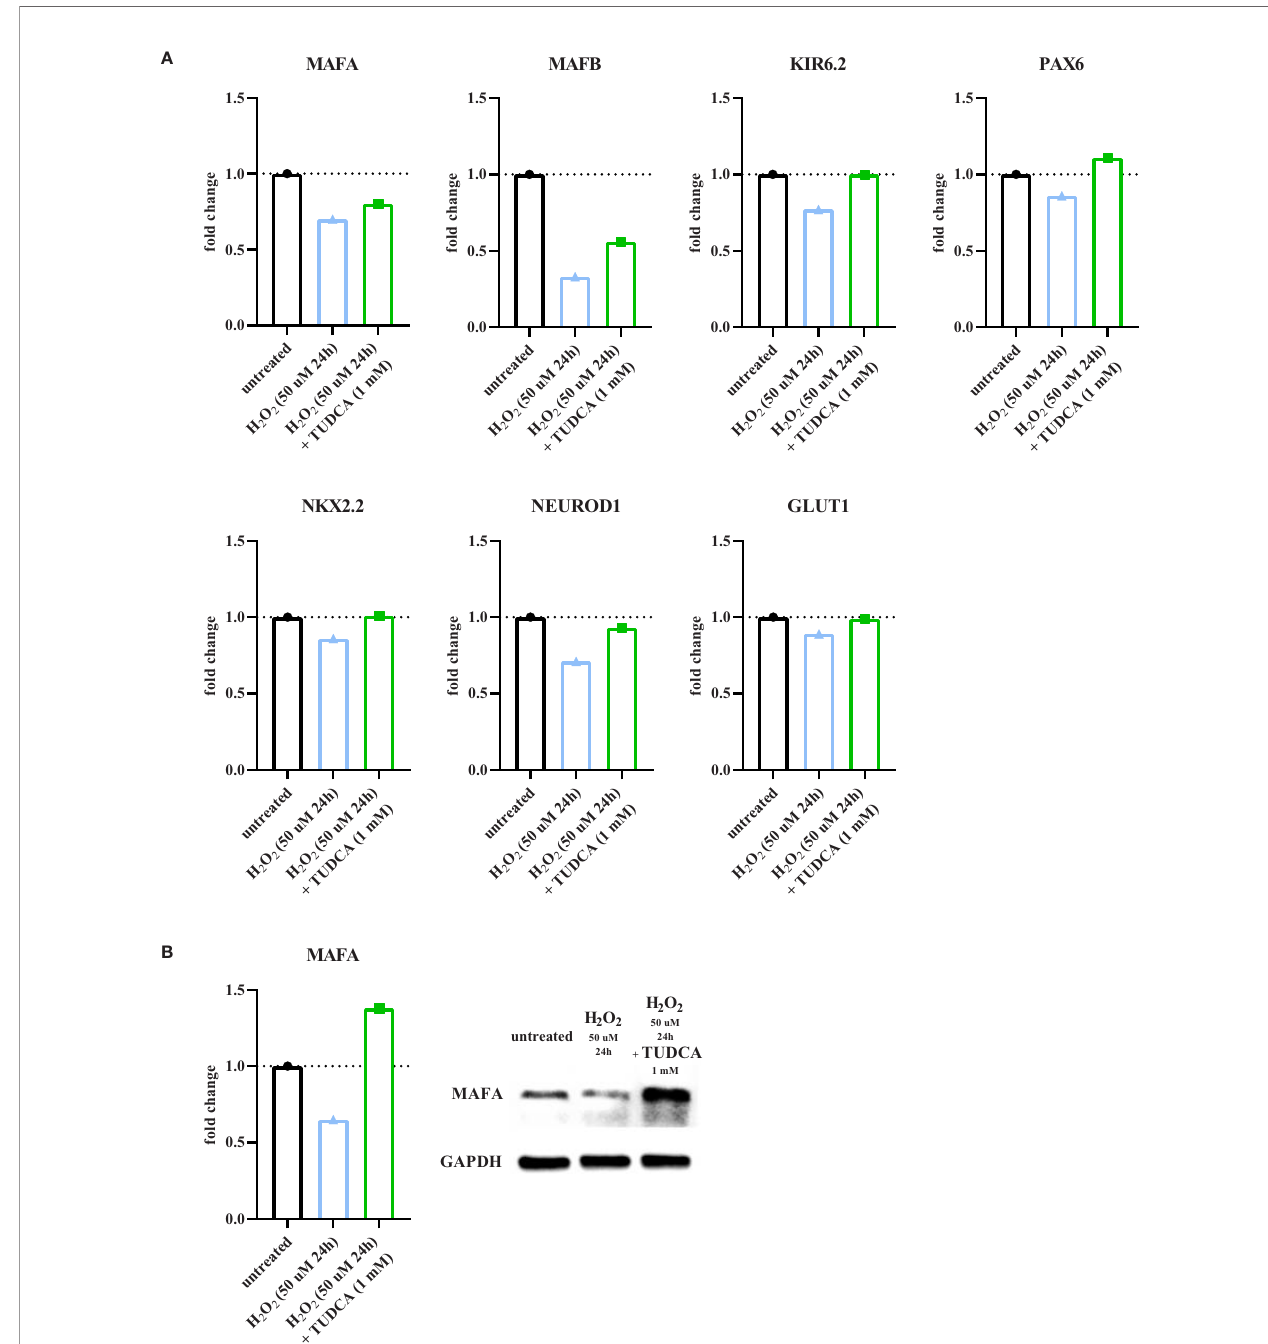
FIGURE 3 | TUDCA partially prevents oxidative stress-induced detrimental effects. To evaluate the effect of tauroursodeoxycholic acid (TUDCA) on oxidative stress- induced detrimental effects, primary human islets were pre-incubated overnight with TUDCA prior to the H 2 O 2 treatments as shown in Supplementary Figure 1A , as well as co-incubated together with H 2 O 2 for the duration of the treatments. (A) TUDCA partially or completely recovers the oxidative stress-induced decreased mRNA expression levels of the genes MAFA, MAFB, KIR6.2, PAX6, NKX2.2, NEUROD1 and GLUT1 in human islets as measured by qPCR. (B) The oxidative stress- induced decreased level of the b -cell-speci fi c protein MAFA is recovered by TUDCA in human islets as measured by Western blot. Data are presented as means of technical triplicates as fold change over untreated control islets (blue graphs). n = 1 donor; Black circles = untreated control islets, upward-pointing triangles = H 2 O 2 - treated islets (50 m M 24h), downward-pointing triangles = H 2 O 2 -treated islets (200 m M 90min), green squares = H 2 O 2 (50 m M 24h or 200 m M 90min) and TUDCA (1 mM) pre- and cotreated islets. h = hours, min = minutes, H 2 O 2 = hydrogen peroxide, TUDCA = tauroursodeoxycholic